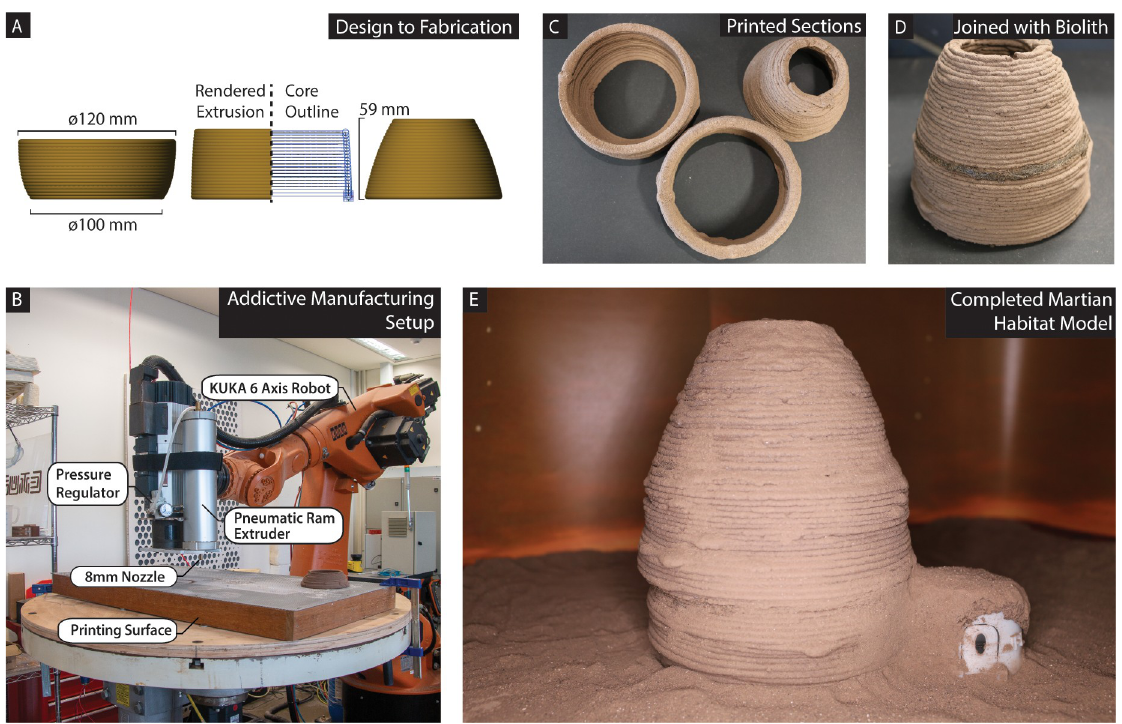
Fig 4. Usage of biolith in additive manufacturing. (A) A scaled model was created in three sections with varying degrees of overhang; (B) The additive manufacturing setup features a pneumatic ram extruder mounted onto a 6-axis robotic arm. Pressure is regulated to directly control the flow of material and used to match the translational speed of the robotic arm. Hot air is manually focused on extruded layers to accelerate water evaporation; (C) Printed sections after drying; (D) Sections joined using biolith as mortar; (E) Completed model with a 3D- printed lander module illustrating a possible scenario of fabricating habitats on